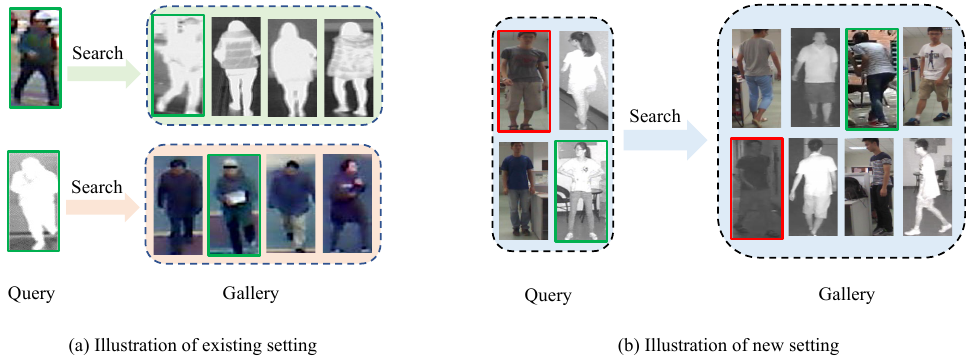
Figure 1. Comparison of two testing settings. Images with the same color of bounding boxes denote the same person identity. ( a ) The query and gallery only contain images from single modality. ( b ) Both the query and gallery contain images from two modalities.